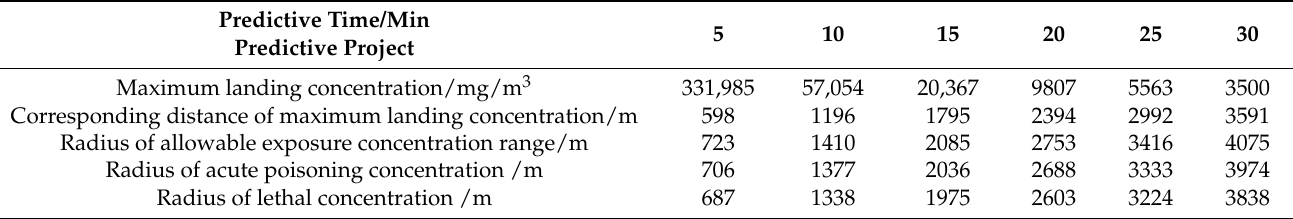
Table 2. Statistical table of prediction results of HF leakage and diffusion with D level atmospheric stability). Predictive Time/Min